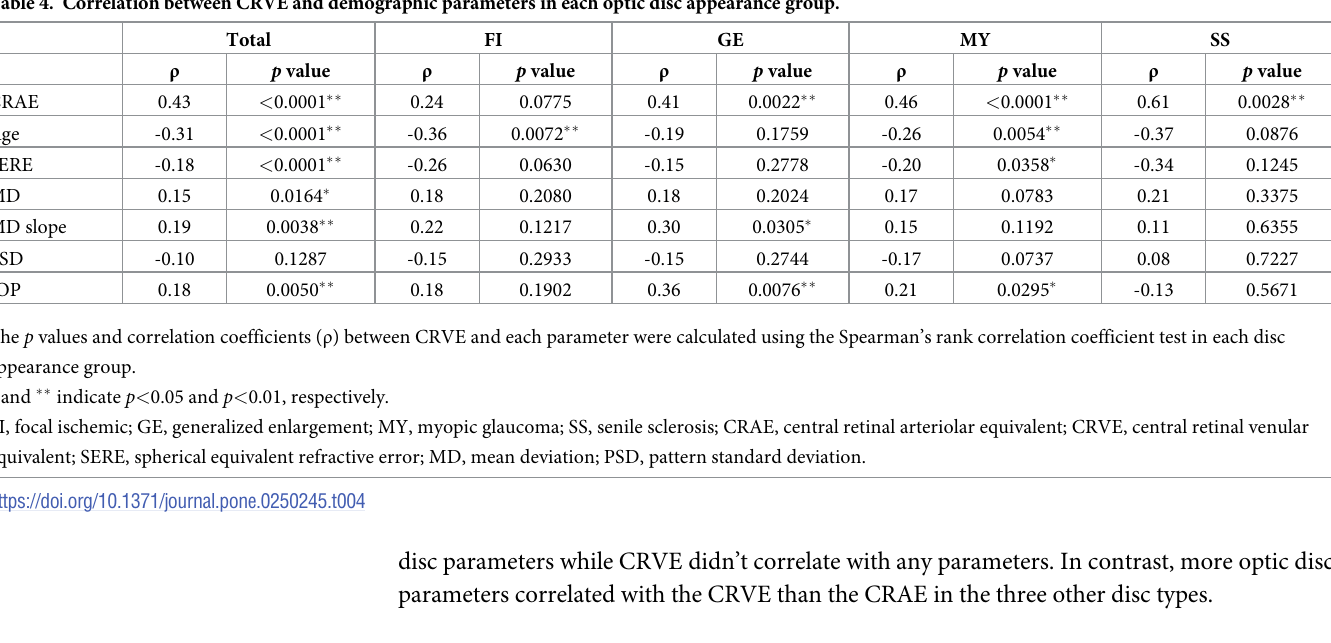
Table 4. Correlation between CRVE and demographic parameters in each optic disc appearance group.